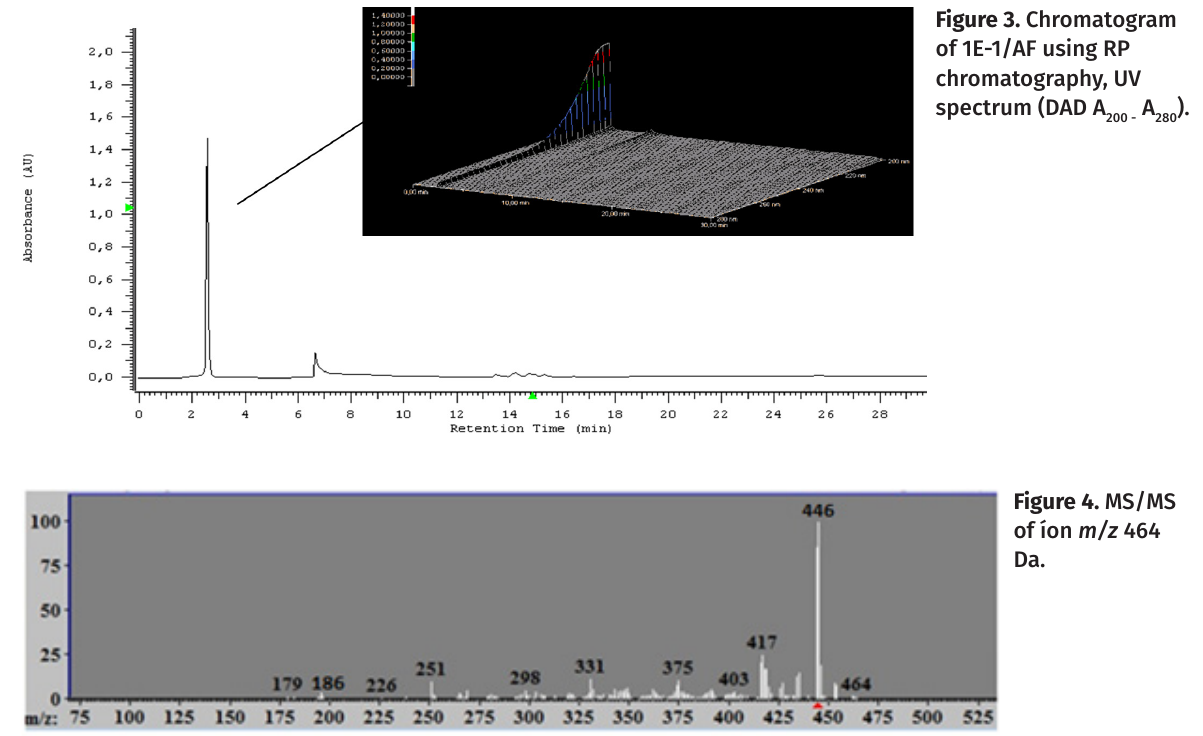
Figure 2. Chromatogram of aqueous fraction (AF) separation using ion-exchange chromatography.